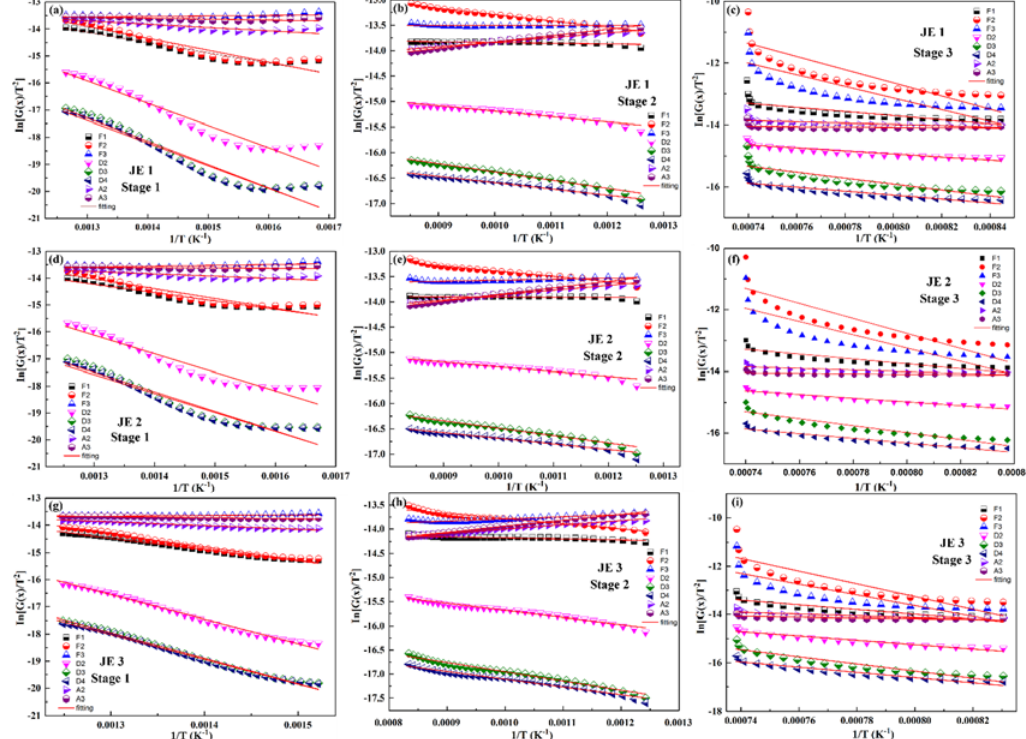
Figure 7. Linear fitting of the mechanism function at the different stages of the coal-iron ore briquette reaction: ( a ) linear fitting of JE1 at reaction stage 1, ( b ) linear fitting of JE1 at reaction stage 2, ( c ) linear fitting of JE1 at reaction stage 3, ( d ) linear fitting of JE2 at reaction stage 1, ( e ) linear fitting of JE2 at reaction stage 2, ( f ) linear fitting of JE2 at reaction stage 3, ( g ) linear fitting of JE3 at reaction stage 1, ( h ) linear fitting of JE3 at reaction stage 2, ( i ) linear fitting of JE3 at reaction stage 3. Table 8. Kinetic parameters of the coal/coal-iron ore briquette at different reaction stages Samples